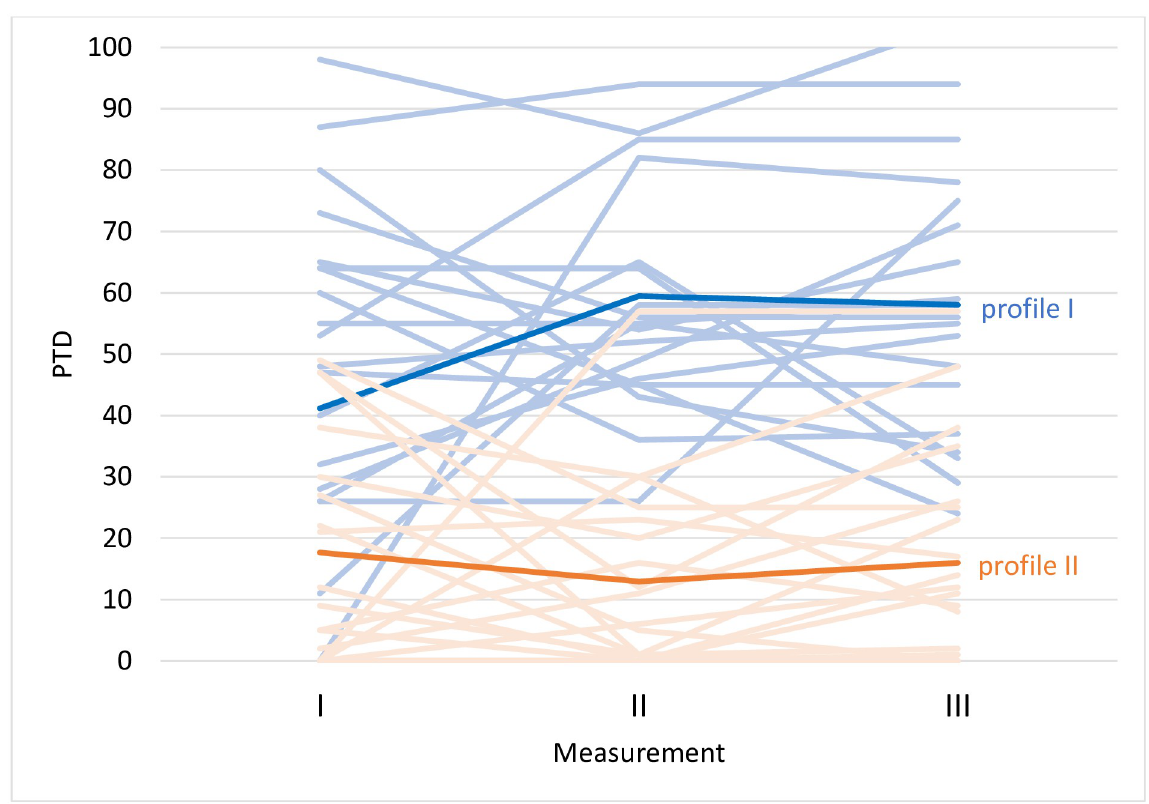
Fig 2. Detected profiles of trajectories regarding changes in PTD. The two extracted profiles detected in at least 20% of cases in the sample are highlighted (i.e., the model with the lowest value of Bayesian Information Criterion